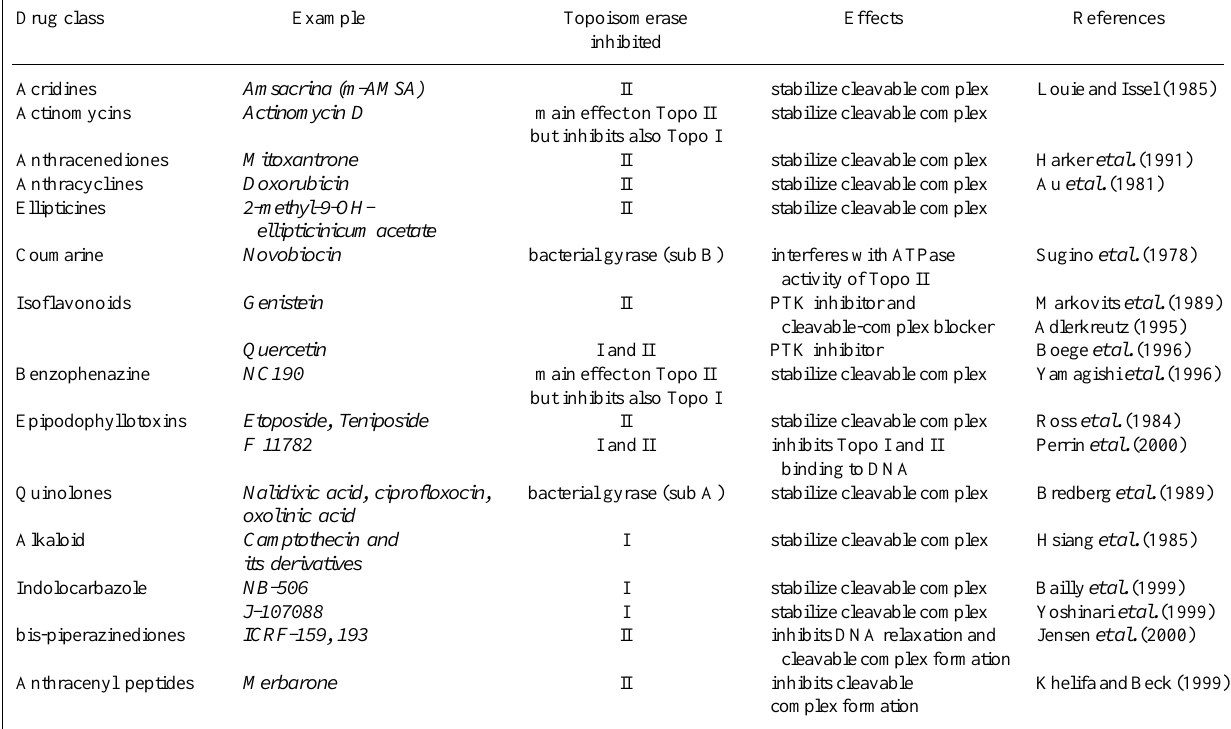
Table I - Anti-topoisomerase